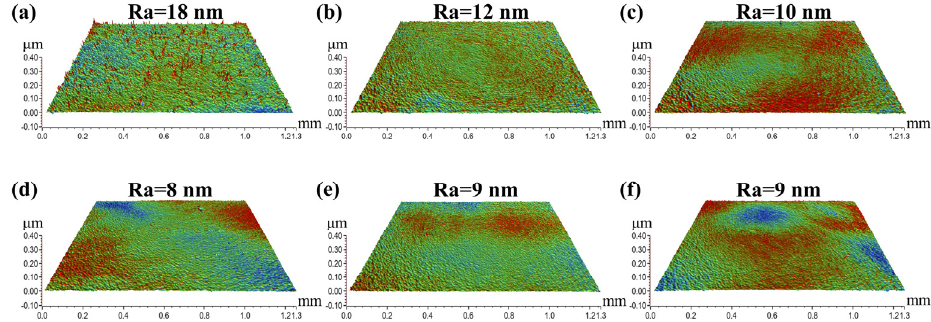
Figure 6. The surface roughness of ( a ) TiCrN, ( b ) TM0, ( c ) TM1, ( d ) TM2, ( e ) TM3, and ( f ) TM4 coatings.